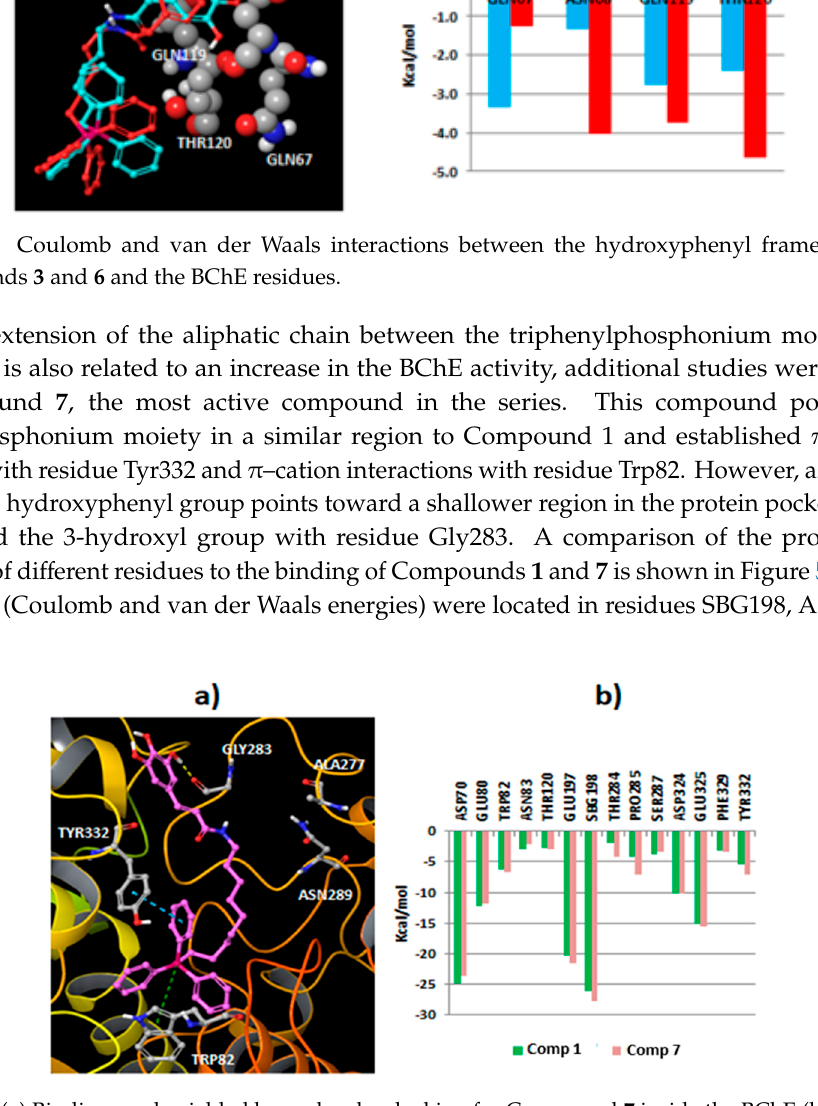
Figure 5. ( a ) Binding mode yielded by molecular docking for Compound 7 inside the BChE (hydrogen bonds: yellow dashes, π –cation interactions: green dashes, π – π stacking interactions: blue dashes); ( b ) Residue contributions (sum of Coulomb and van der Waals energies) to the binding between the BChE and Compounds 7 (magenta color) and 1 (green color).